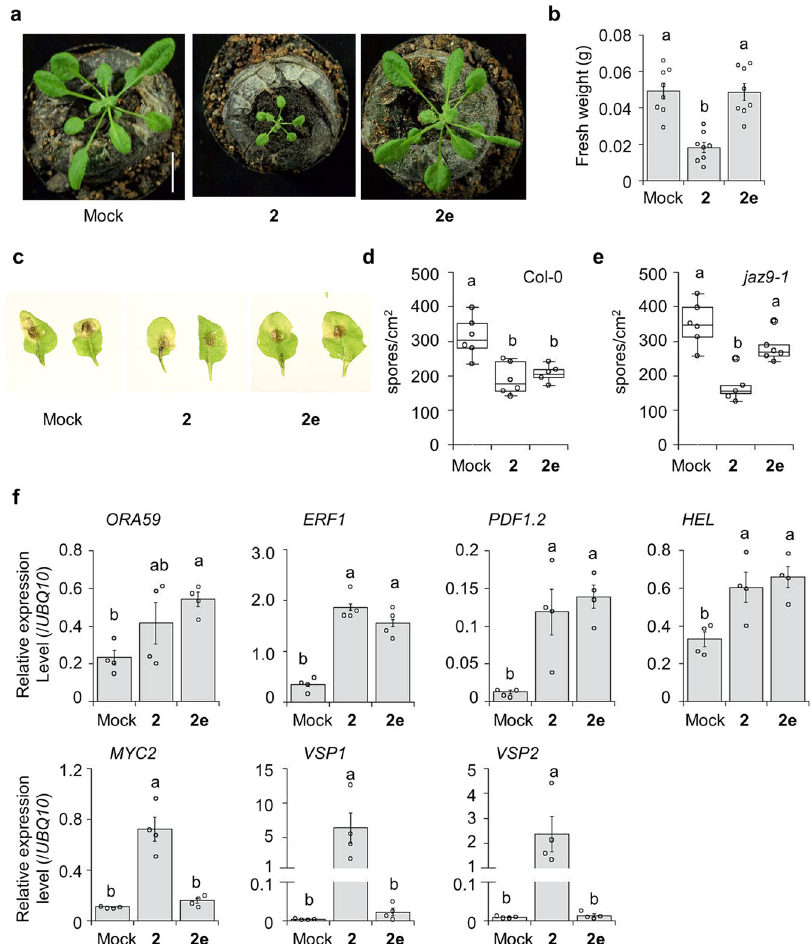
Fig. 3 In planta analyses of stereoisomers in Arabidopsis thaliana . a , b Growth inhibition assay using ligand-treated 4-week-old A. thaliana . a Representative images of the 2 - (50 µ M) and 2e -treated (50 µ M) plants. Similar results were obtained in three independent experiments (Supplementary Fig. 12). Scale bar: 1.0 cm. b Quanti fi cation of fresh weight of aerial part of the ligand-treated plants ( n = 8). Signi fi cant differences were evaluated by one- way ANOVA/Tukey HSD post hoc test ( p < 0.05). Values are mean ± SE. c – e Fungal infection assay using c , d 4-week-old Col-0 and e 4-week-old jaz9-1 . Plants were treated with mock solution, 2 or 2e (50 μ M) and infected with A. brassicicola ( n = 7). c Representative images of leaves infected with A. brassicicola are shown in ( d ) and ( e ). Quanti fi cation of fungal spores was undertaken 5 days after inoculation; the results are depicted using box plots; horizontal lines are medians, boxes show the interquartile range, and error bars show the entire data range. Signi fi cant differences were evaluated by one- way ANOVA/Tukey HSD post hoc test ( p < 0.05). Experiments were repeated three times with similar results. Values are mean ± SE. f Gene expression analysis in 4-week-old A. thaliana with or without compound treatment (50 µ M, n = 4) without pathogen inoculation. Each sample was fl ash-frozen after 8 h from de fi nitive treatment. Similar results were obtained in three independent experiments. Signi fi cant differences were evaluated by one-way ANOVA/ Tukey HSD post hoc test ( p < 0.05). Values are mean ±